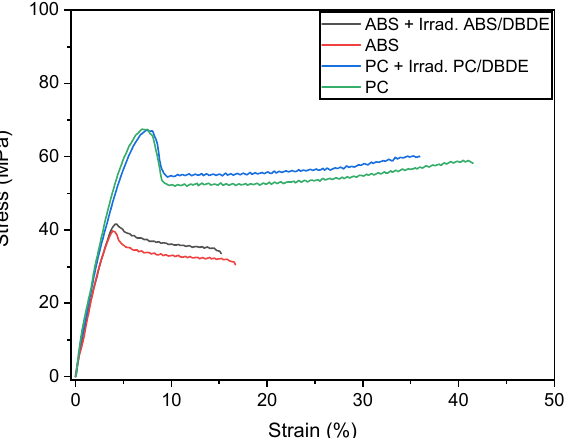
Figure 7. DSC thermograms of virgin and irradiated ABS, PC, 90 wt-% ABS/10 wt-% DBDE, and 90 wt-% PC/10 wt-% DBDE samples. The temperatures given in this figure correspond to the glass transition.